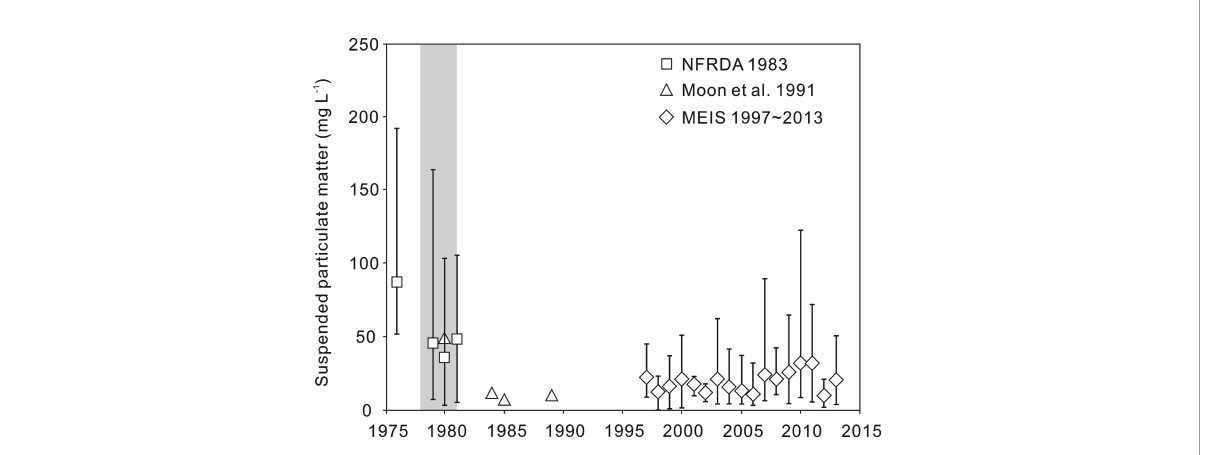
FIGURE 5 Annual mean values and ranges of suspended sediment concentrations for one year prior to (1976), during (1979 – 1981, shaded area), and after dam construction, until 2013 (MEIS 1997 – 2013; NFRDA 1983; Moon et al.,